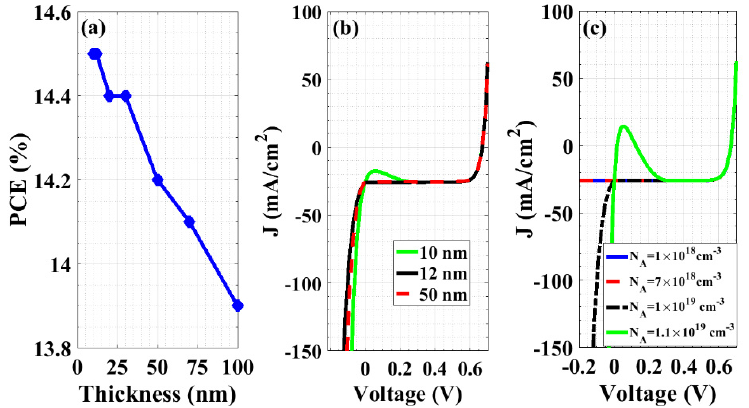
Figure 6. ( a ) Effect of the thickness of the RCL on the performance of the self-protected structure, ( b ) J-V curves for the RCL thickness of 10 nm, 12 nm, and 50 nm, and ( c ) J-V curves for different doping concentrations of the RCL.